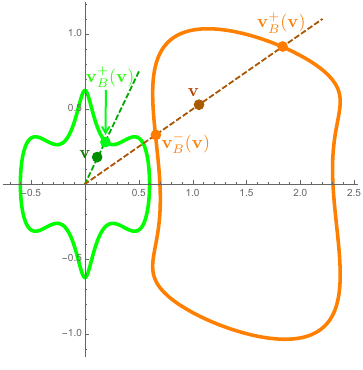
and for (cid:12) = 2 (cid:25) . B